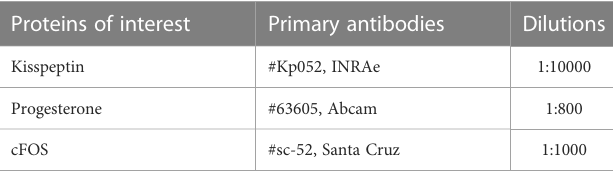
TABLE 1 Primary antibodies